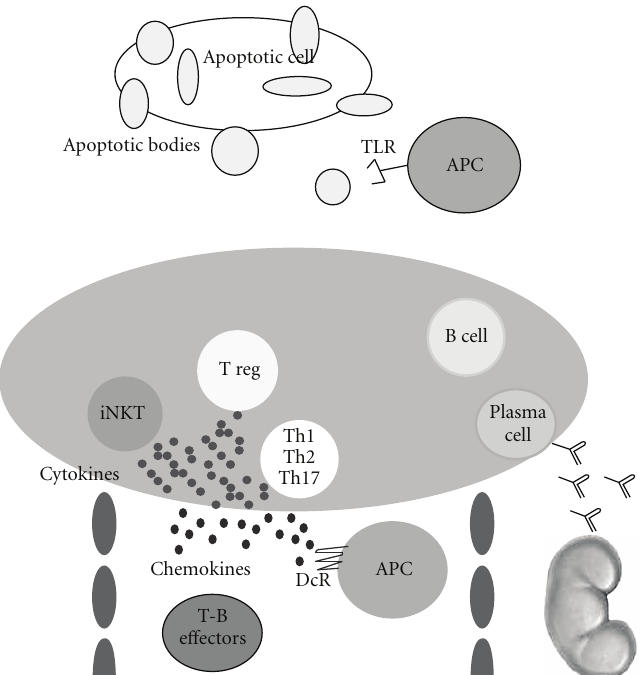
Figure 1: Mechanisms involved in the pathogenesis of SLE and lupus-like syndromes. Di ff erent cells and receptors contribute to the activation of B cells secreting autoantibodies; these Immunoglobulins cause tissue